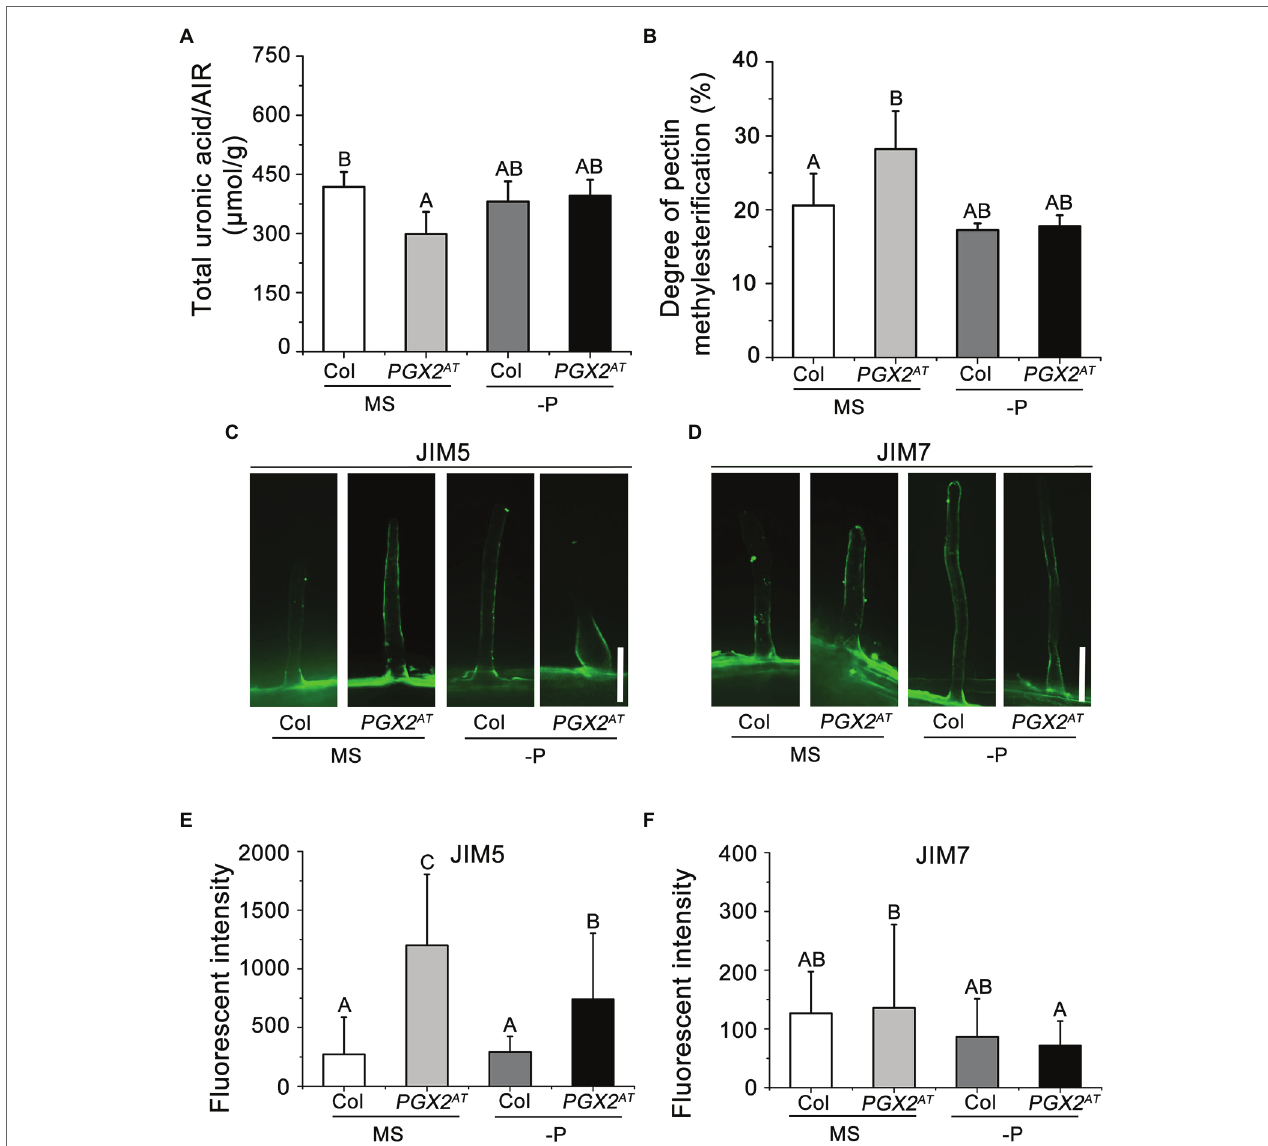
FIGURE 2 | The pectin content and degree of pectin methylesterification are altered in PGX2 AT seedlings. (A,B) Total uronic acid content and degree of pectin methylesterification of seedlings grown in normal MS and low phosphate (-P) conditions ( n = 5 technical replicates). (C,D) Immunolabeling in root hair cells of Col and PGX2 AT seedlings after transferring for 4 days by JIM5 and JIM7, respectively. Bars = 50 μ m. (E,F) Arbitrary fluorescent intensity of immunolabeling images for JIM5 and JIM7 antibodies ( n ≥ 13 root hairs per each genotype). Error bars represent SD. Uppercase letters on top of bar charts indicate significantly different groups as determined by one-way ANOVA with post-hoc Duncan’s test ( p <